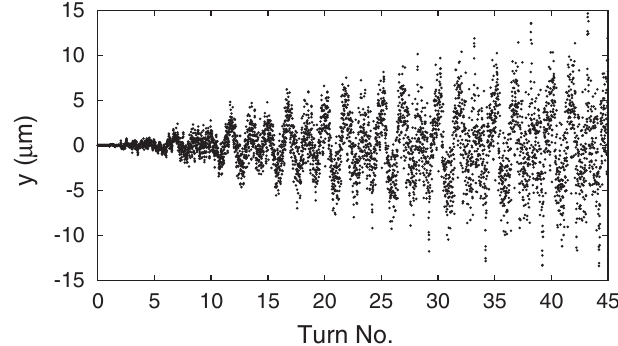
FIG. 2. The vertical jitter (displacement) of each bunch at the extraction location is recorded, just before it is extracted. The horizontal axis is the time, in units of revolution time.